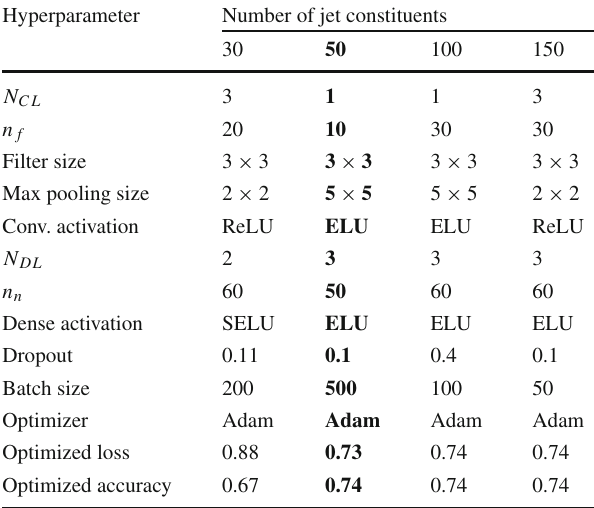
Table 5 Optimal CNN hyperparameter setting for different input data